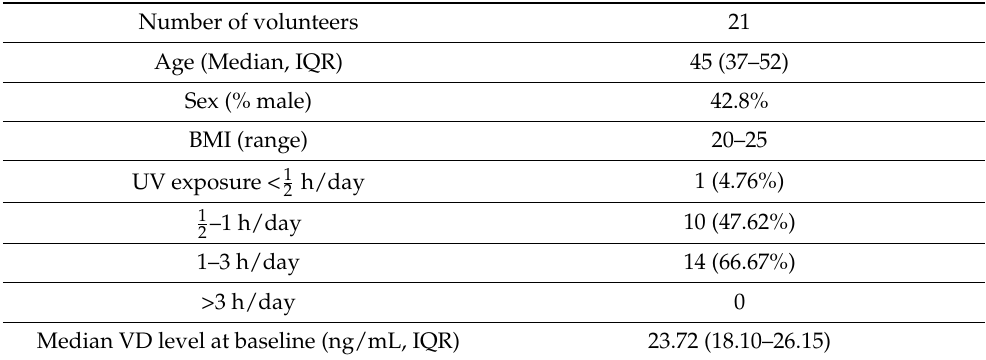
Table 3. Volunteers’ characteristics at the